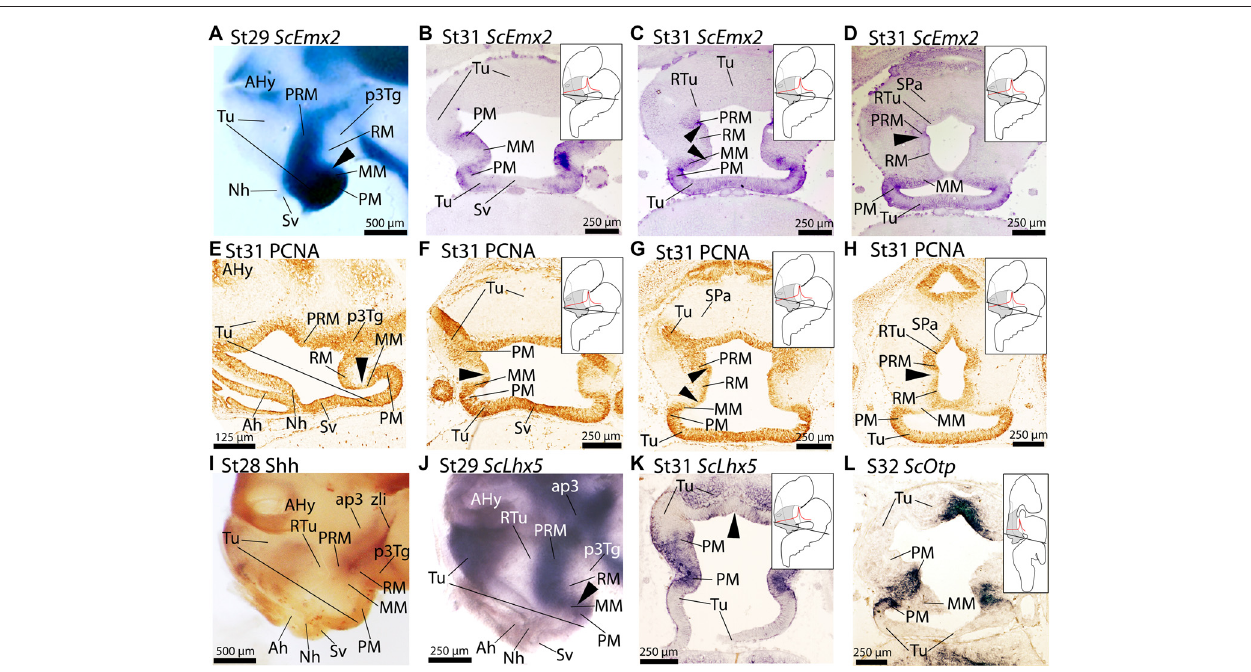
FIGURE 3 | Regionalization of the basal hypothalamus and neighbor territories in embryos of S. canicula at stages 29–32 based on the expression of ScEmx2 (A–D) , ScLhx5 (J,K) , ScOtp (L) and immunoreactivity to proliferating cell nuclear antigen (PCNA) (E–H) and Shh (I) on whole mounts (A,I,J) and in sagittal (E) and transverse (B–D,F–H,K,L) sections. (A–D) ScEmx2 expression through the caudo-ventral Tu, PM/PRM and MM domains. Note the absence of expression in the RM domain and in the rostral part of the acroterminal territory. (A) Lateral view of a whole mount. Arrowhead marks the caudal border of the ScEmx2 expression in the MM. Note the sharp limit with the negative RM domain. (B–D) Sequence of sections from ventral (B) to dorsal (D) levels of the basal hypothalamus. Arrowheads in (C) mark how the ScEmx2 expression in the MM and PRM borders the negative territory of the RM. Arrowhead in (D) points the caudal border of ScEmx2